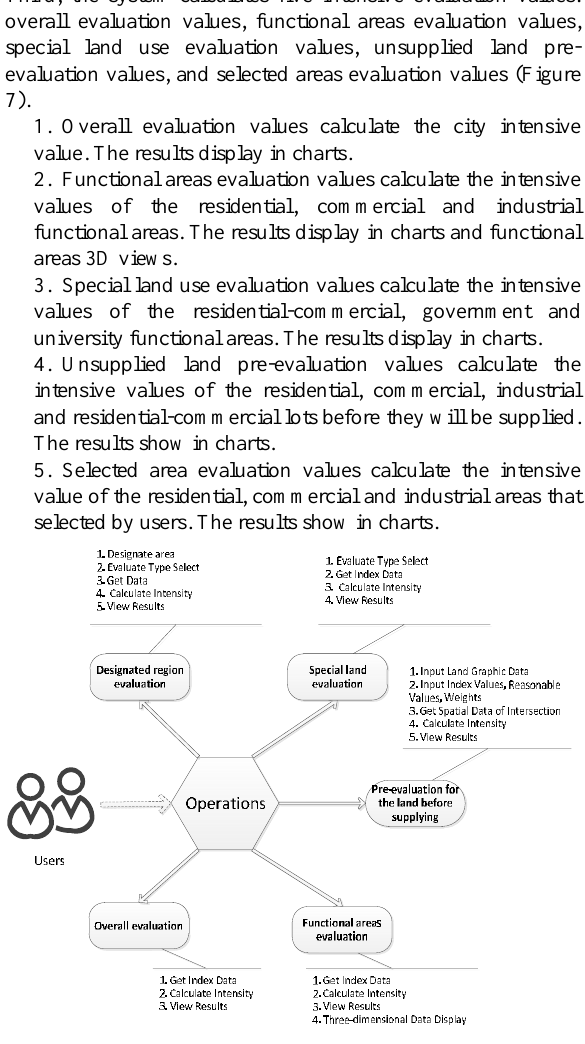
Figure 5. Dynamically build index system model diagram